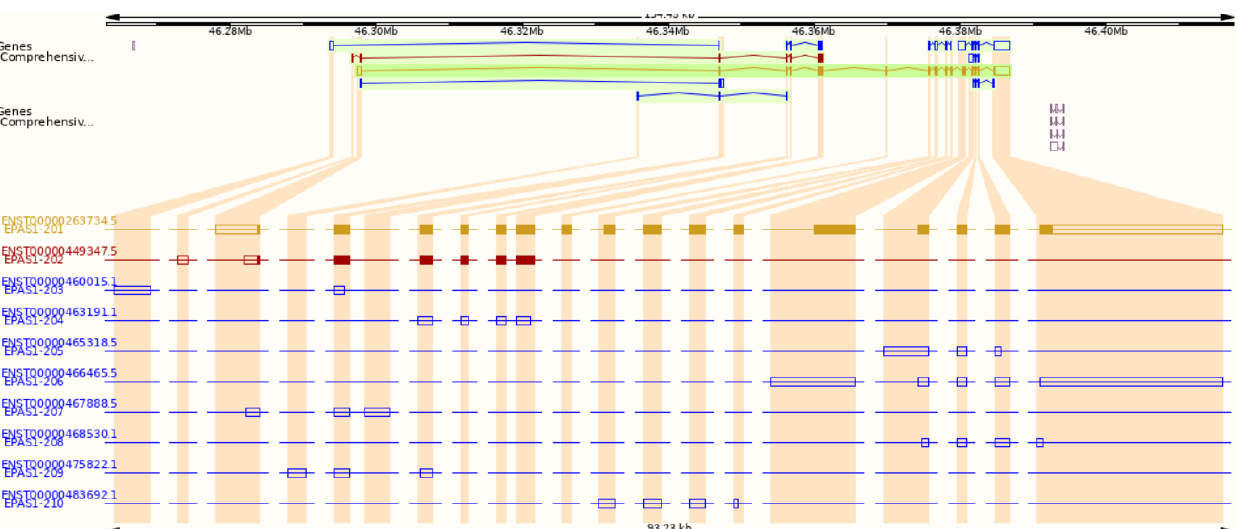
Figure 2. Transcripts of the EPAS1 gene from the Ensembl genome browser. Gold and red indicate protein-coding tran- scripts, blue indicates non-coding transcripts.